Question: From the figure, is the trend upward or downward?
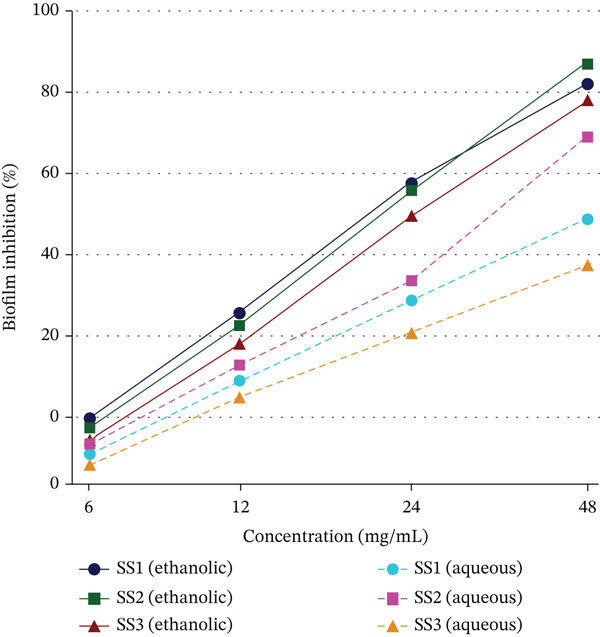
Answer: increasing